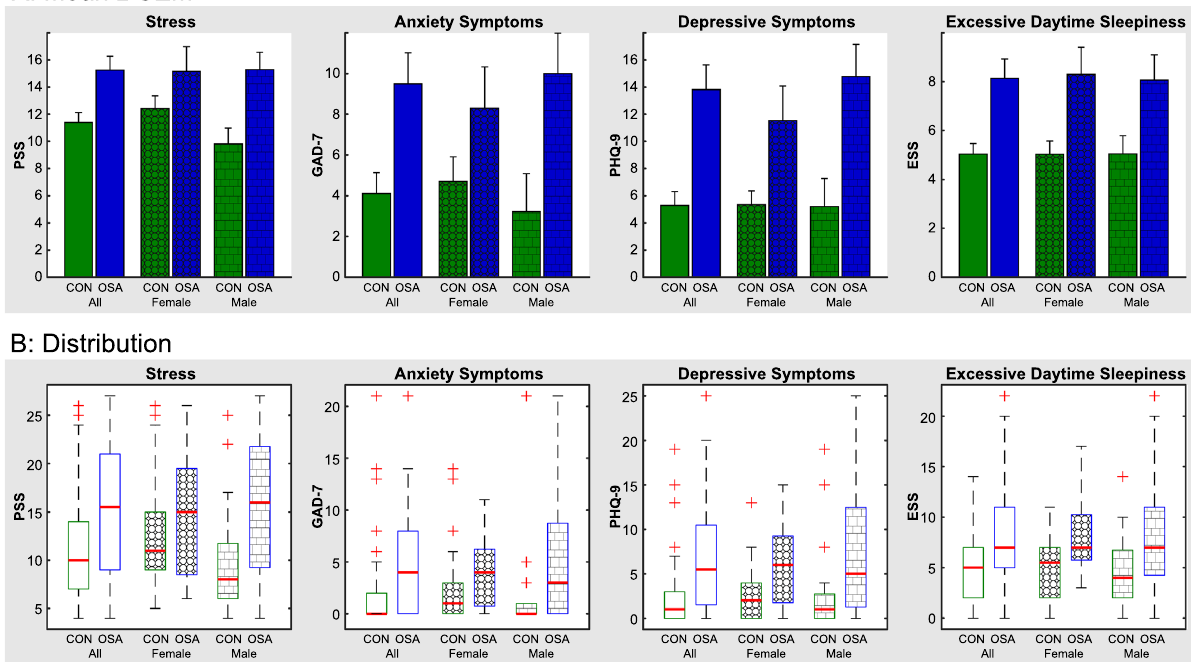
Figure 1. Group Means and distributions of symptoms in OSA. ( A ) Bar graphs of mean ± SEM values and ( B ) distributions of four psychological variables for each group. Green = control, blue = OSA. Plain fill = combined sexes, circle hatching = females, rectangular hatching = males. B: boxplots show lower and upper quartiles (box), median (red line in box), range without outliers (black dashed lines), and outliers (red crosses), where outliers are values more than 1.5 times the interquartile range above the upper quartile or below the below the lower quartile. PSS = Perceived Stress Scale; GAD-7 = Generalized Anxiety Disorder scale; PHQ-9 = Patient Health Questionnaire; ESS = Epworth Sleepiness Scale.